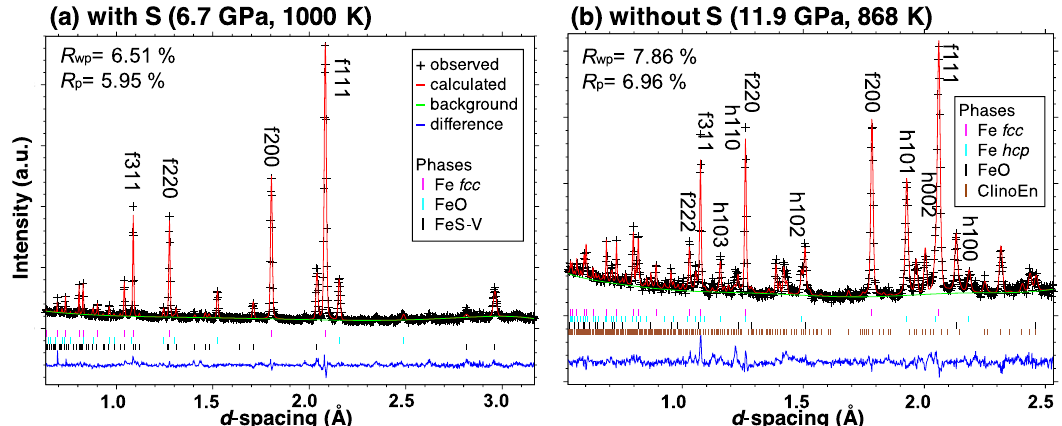
Figure 2. Representative neutron diffraction patterns analyzed using the Rietveld refinement method. ( a ) Hydrous sample with sulfur at 6.7 GPa and 1000 K (#A349) and ( b ) hydrous sample without sulfur at 11.6 GPa and 868 K (#A454). “+ ” denotes the observed data points; the solid line red denotes the calculated profile. The difference between the observed (black+) and the calculated (red) profiles (“diff”) is shown as blue lines at the bottom of each plot. Tick marks below the pattern show the positions of allowed diffraction peaks and hkl for the corresponding phases (f; Fe fcc , h; Fe hcp ). “Clino En” represents the high-PT phase of